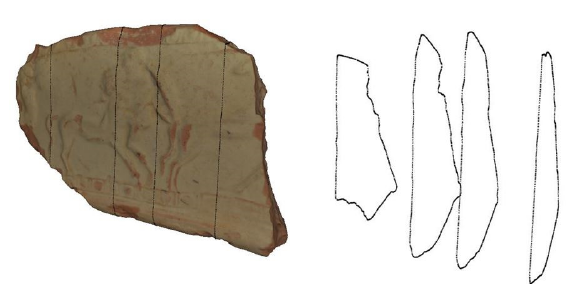
Figure 18. Digital cross sections of the Centauromachia fragment.